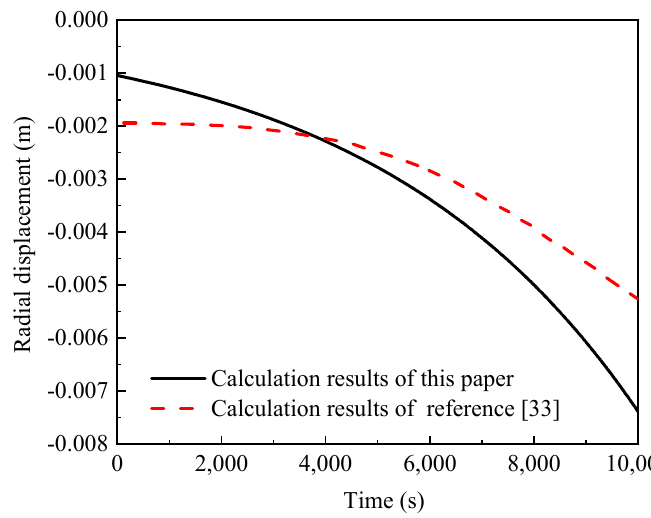
Figure 6. Evolution curves of the velocity of fluid at inner boundary.